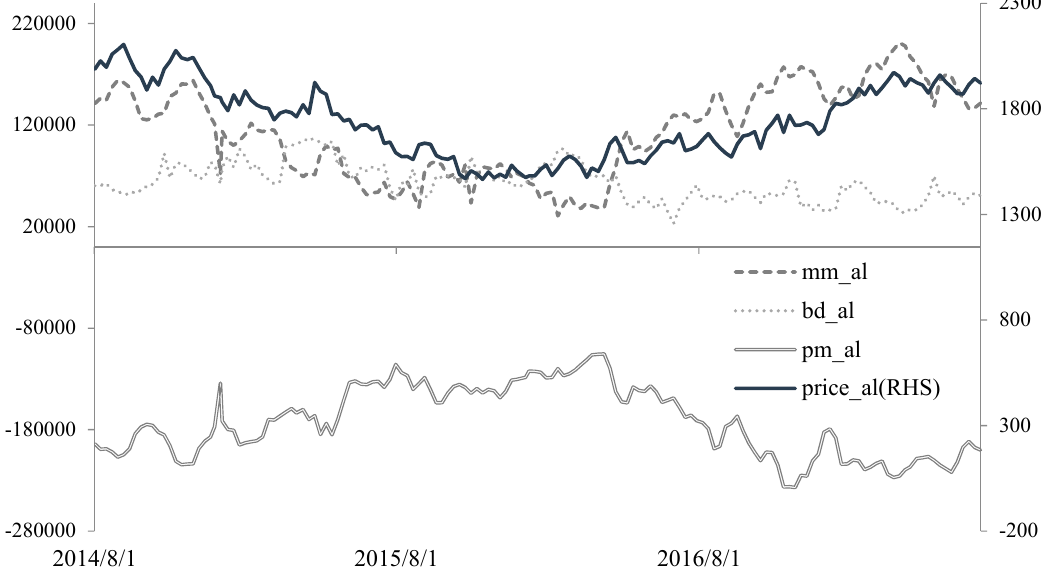
Figure 1. Plot of mm_al and price_al. Notes: The solid line is the price of aluminum on the LME over the period August 2014 to July 2017, while the bold dotted line is aluminum’s net position trend for a money manager. The thin dotted line is aluminum’s net position trend for a broker–dealer / index trader and the double line is aluminum’s net position trend for a producer / merchant reveal with a somewhat different shape and indifferent from the price of aluminum.